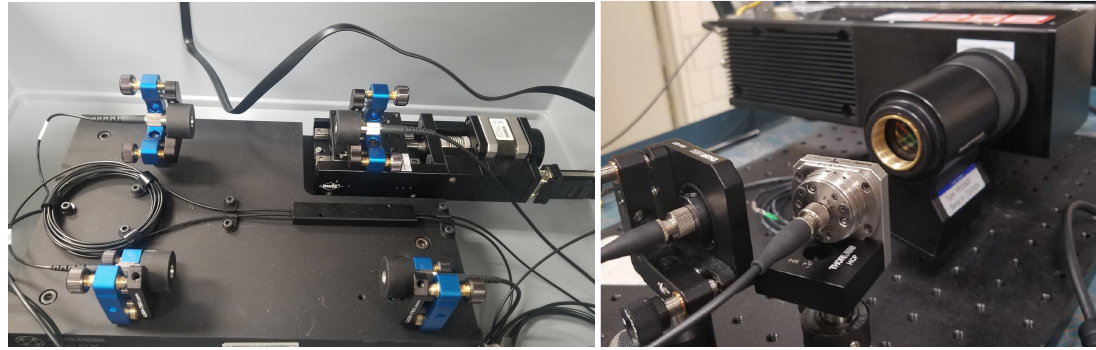
Figure 4. Left: photograph of the HOM interferometer with optical delay and beam splitter. Right: photograph of Tpx3Cam with two fibers pointing to the intensifier photocathode.